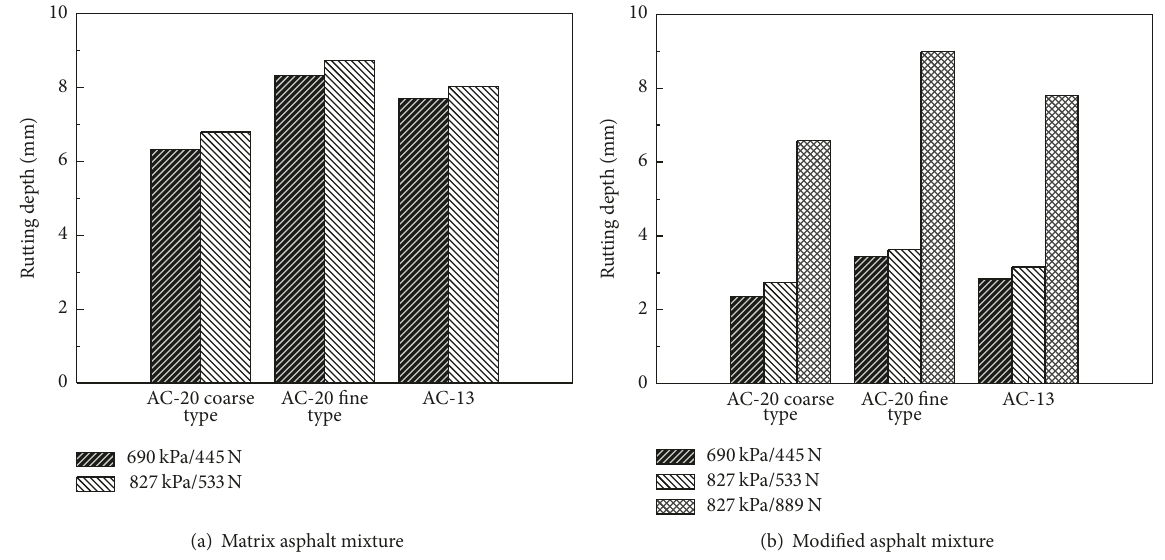
Figure 5: APA rutting depths of asphalt mixtures at different combinations of load and tire pressure.